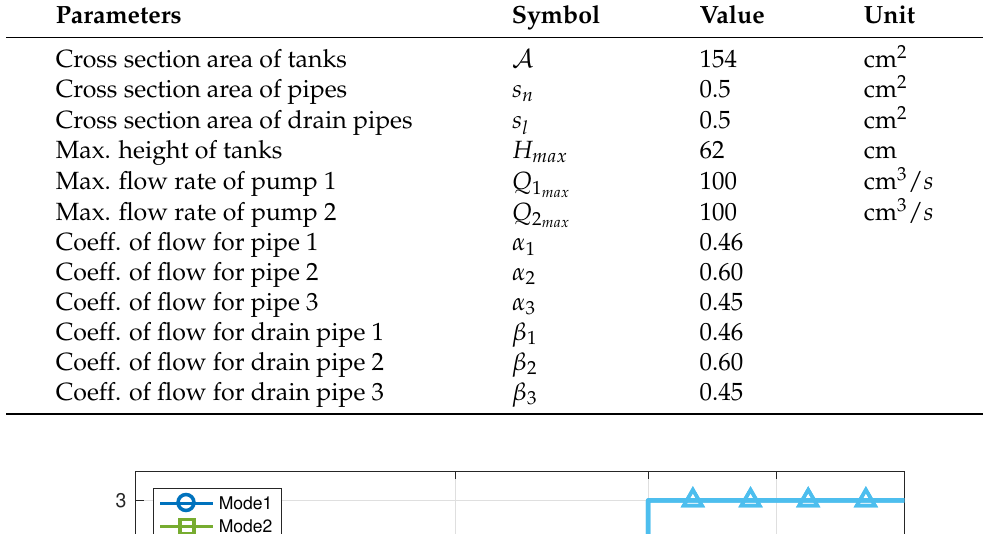
Table 2. Parameters of the three-tank model.